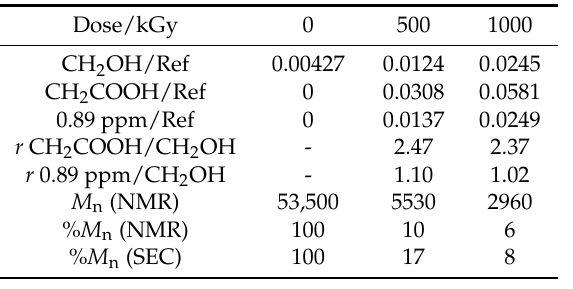
Table 1. Calculations from proton nuclear magnetic resonance (NMR) spectra for PCL 50 K non-irradiated and irradiated at 500 and 1000